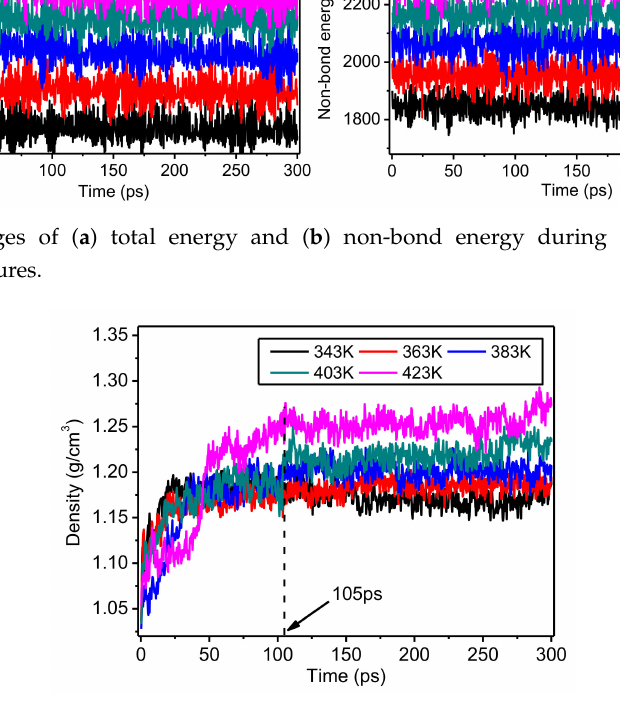
Figure 9. Change of density of amorphous regions of meta-aramid fibers during simulations at different